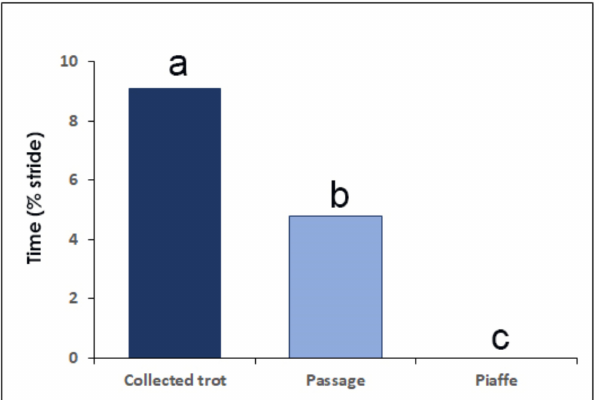
Figure 3. Mean values of aerial phase duration expressed as percentage of stride duration in collected trot, passage and pia ff e [25]. Di ff erent letters (a,b,c) above the columns indicate values that di ff er significantly ( p <